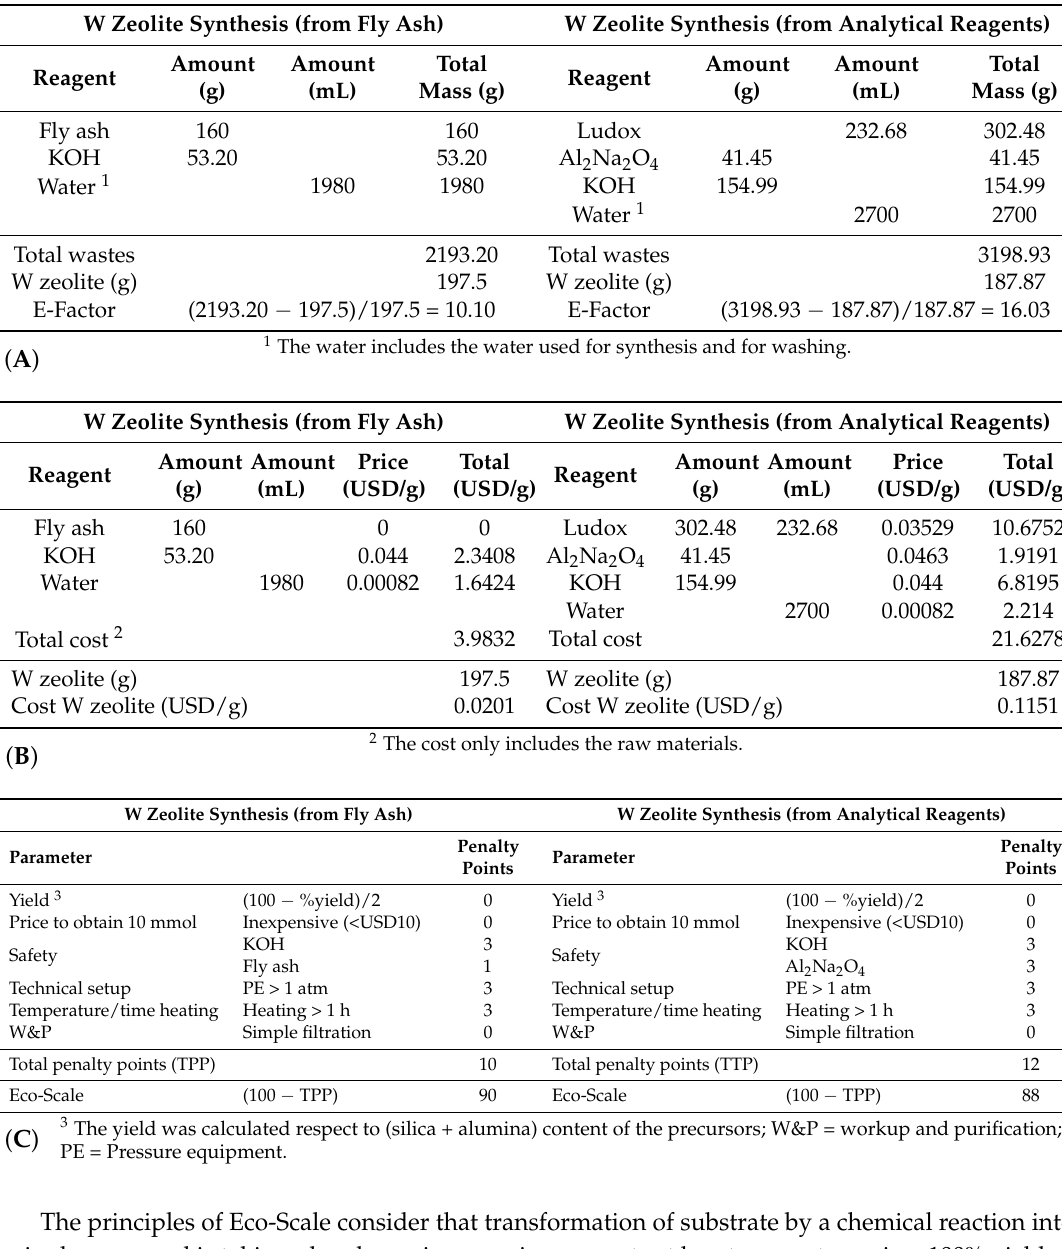
Table 3. E-Factor, cost and Eco-Scale applied to synthesis of W zeolite comparing the type of precursors. ( A ) E-Factor; ( B ) Cost; ( C )